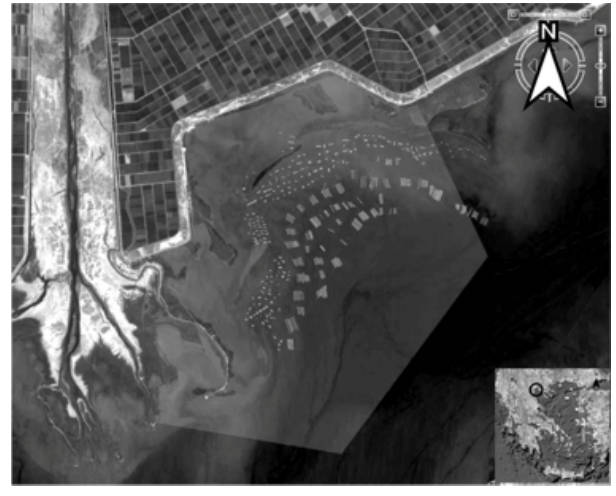
Fig. 1 . The mussel-farming area of Chalastra in the Thermaikos Gulf (from Google